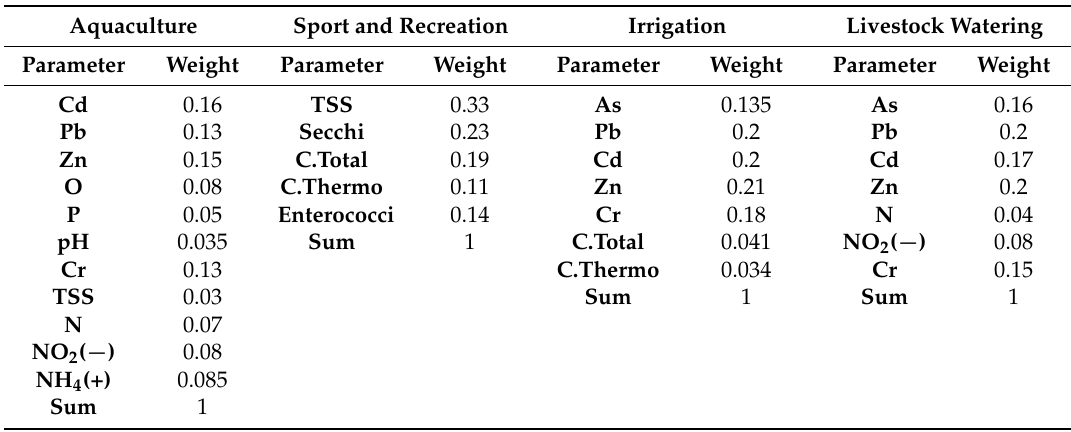
Table 4. Parameter weights for different